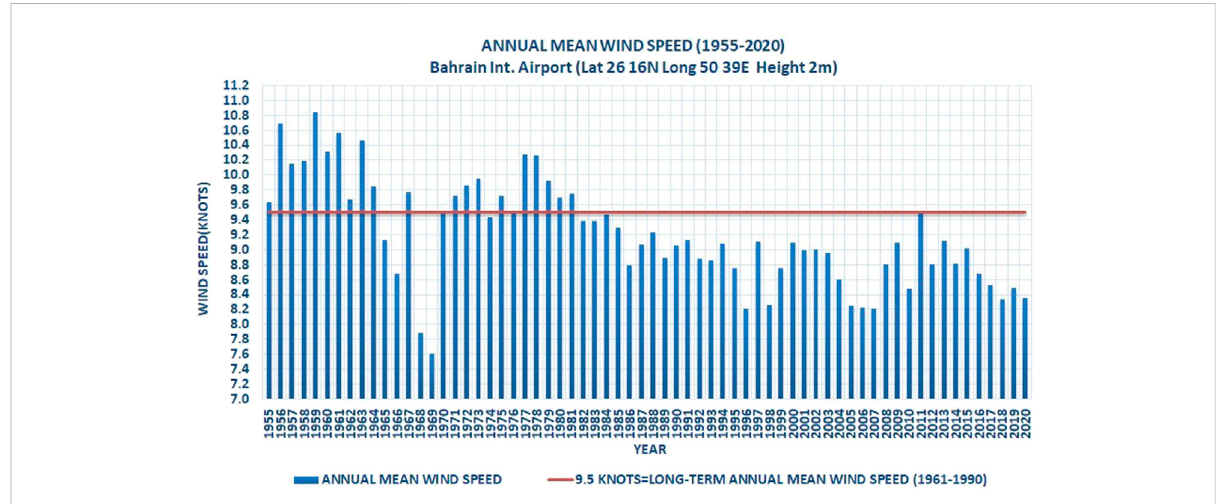
FIGURE 6 Variation of annual mean average wind speed in the Kingdom of Bahrain from 1955 to 2020. The long-term annual mean speed is 9.5 knots = 4.75 m/s = 17.1 km/h (average of data from 1961 to 1990).